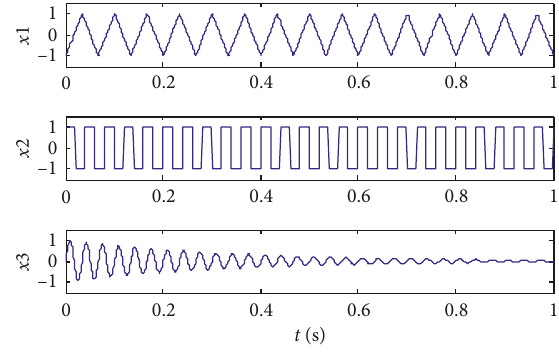
Figure 4: The original simulation